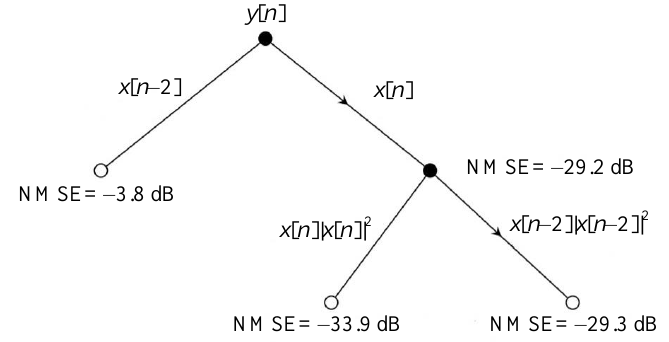
Figure 3. Decision tree representation of a GMP model.